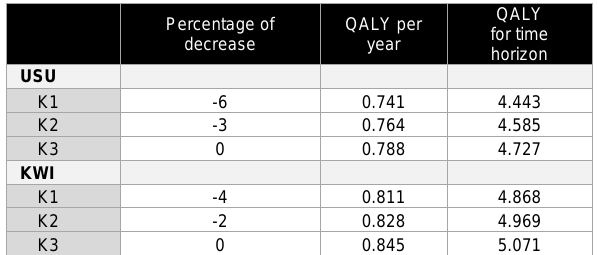
Table 5: Assumed percentage of utility gained in relation of baseline of 0.788 QALY per year and 0.845 QALY per year extracted from Guirao et al (2018) as well as total QALY for time horizon following the provision of transfemoral socket-suspended prostheses attached to residuum without (USU) and with distal weight bearing Keep Walking Implant (KWI) for each K-Level (K1, K2, K3), respectively. 22